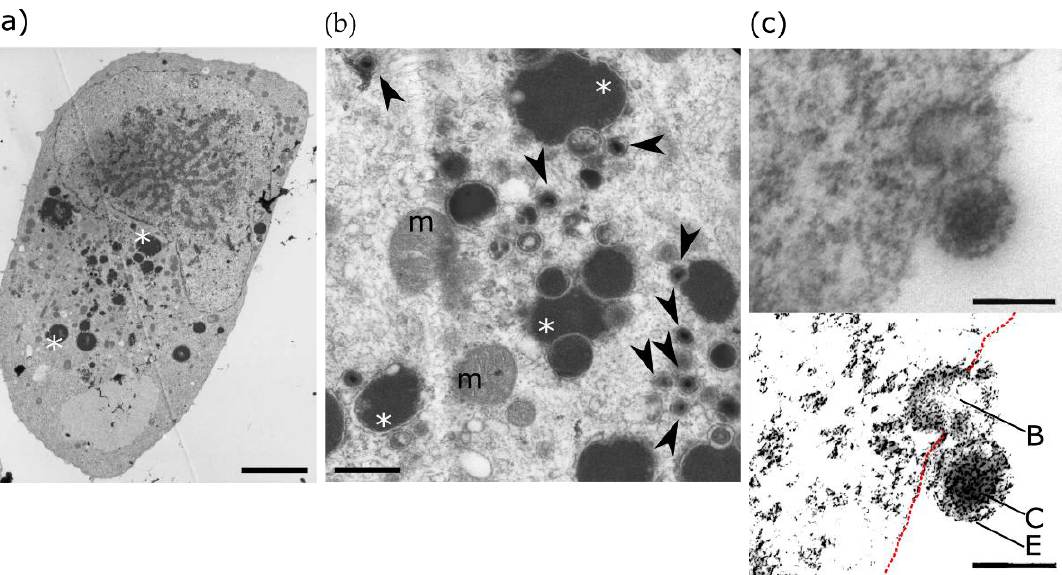
Figure 2. Transmission electron microscopy of human NSC cultures infected by HCMV. ( a ) Representative HCMV-infected NSC, containing numerous electron-dense lipid droplets (asterisks) consistent with active PPARγ. Scale bar: 5 µm. ( b ) Representative view of the cytoplasm of an infected NSC, containing morphologically mature viral particles (arrowheads) mitochondria (m) and still lipid droplets. Scale bar: 0.5 µm. ( c ) View of a HCMV particle shedding from an infected cell (top) and the same view after image processing (bottom) to highlight plasma membrane (red dotted line), the exocytosis cavity (B), the viral capsid (C) containing the electron-dense viral chromatin and the viral envelope (E). Scale bar: 0.2 µm.